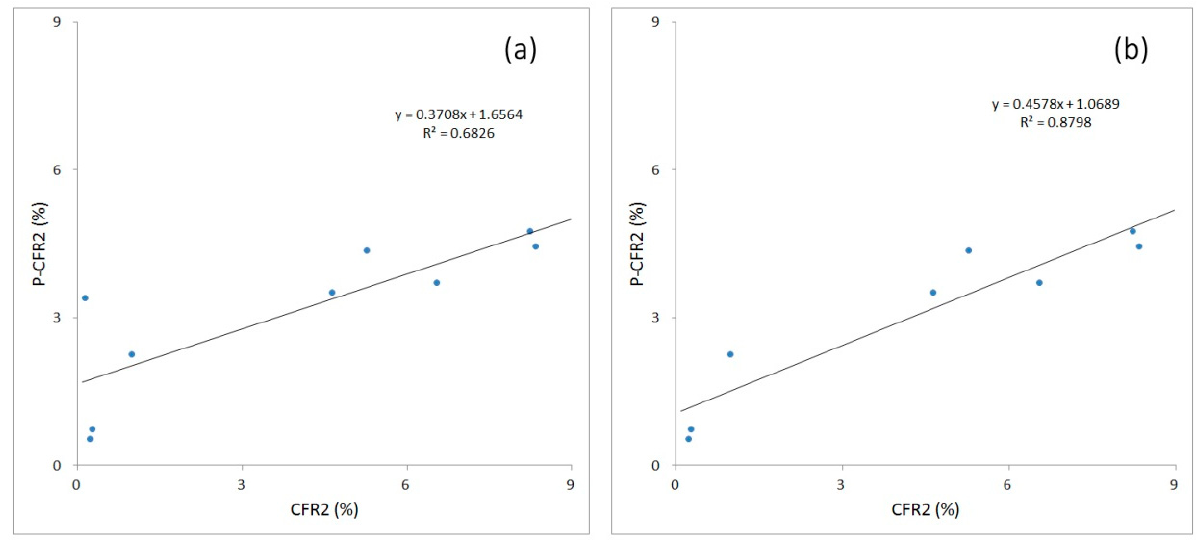
Figure 6. Prediction performance of CFR2 for initial COVID-19 epidemics with established model M1 for nine nations ( a ) or eight nations ( b ) in external evaluation. CFR2 values: calculated from the existing national CFR curves. p-CFR2 values: predicted from model M1.